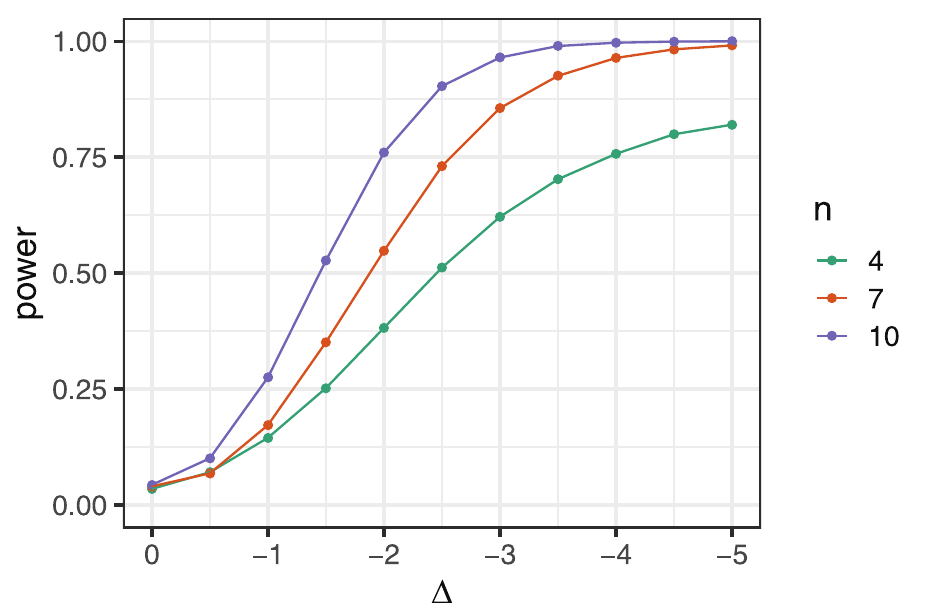
Fig 5. Power of the exact gene pair placement test. The power of the exact placement test as we increase the effect size Δ , which is the change in clonal exclusivity rate on the logit scale, for different sample sizes.